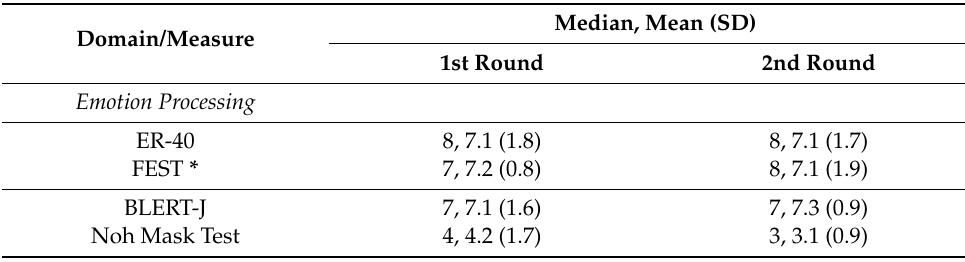
Table 2. Results of the expert panel